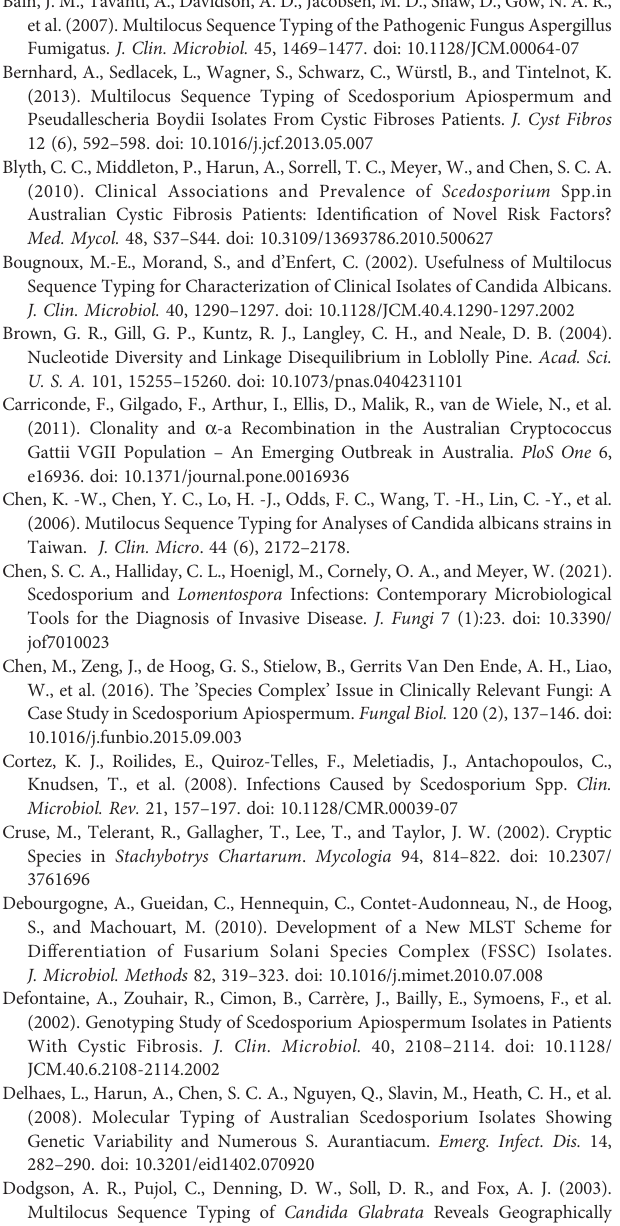
Supplementary Figure 4 | RPB2 locus tree. Most parsimonious tree for the RPB2 locus for the 188 investigated Scedosporium aurantiacum isolates obtained with the program MEGA version 11 (numbers on the branches indicate bootstraps values above 50). Supplementary Figure 5 | SOD2 locus tree. Most parsimonious tree for the SOD2 locus for the 188 investigated Scedosporium aurantiacum isolates obtained with the program MEGA version 11 (numbers on the branches indicate bootstraps values above 50). Supplementary Figure 6 | TUB locus tree. Most parsimonious tree for the TUB locus for the 188 investigated Scedosporium aurantiacum isolates obtained with